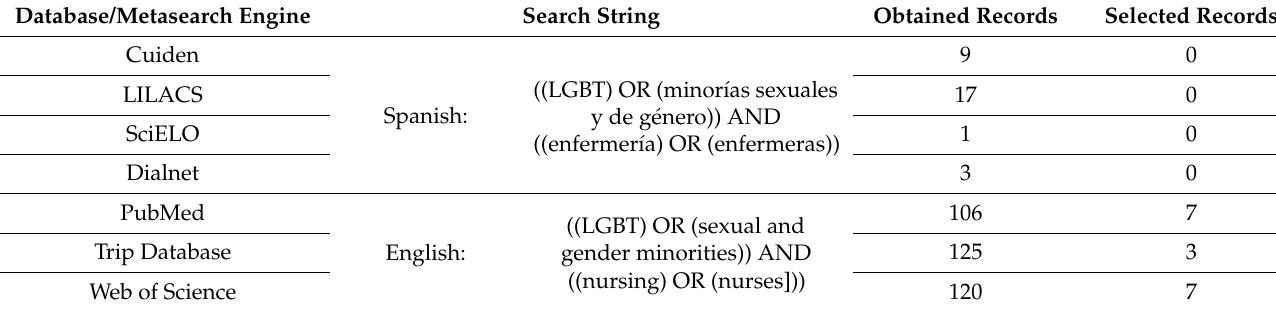
Table 1. Database search